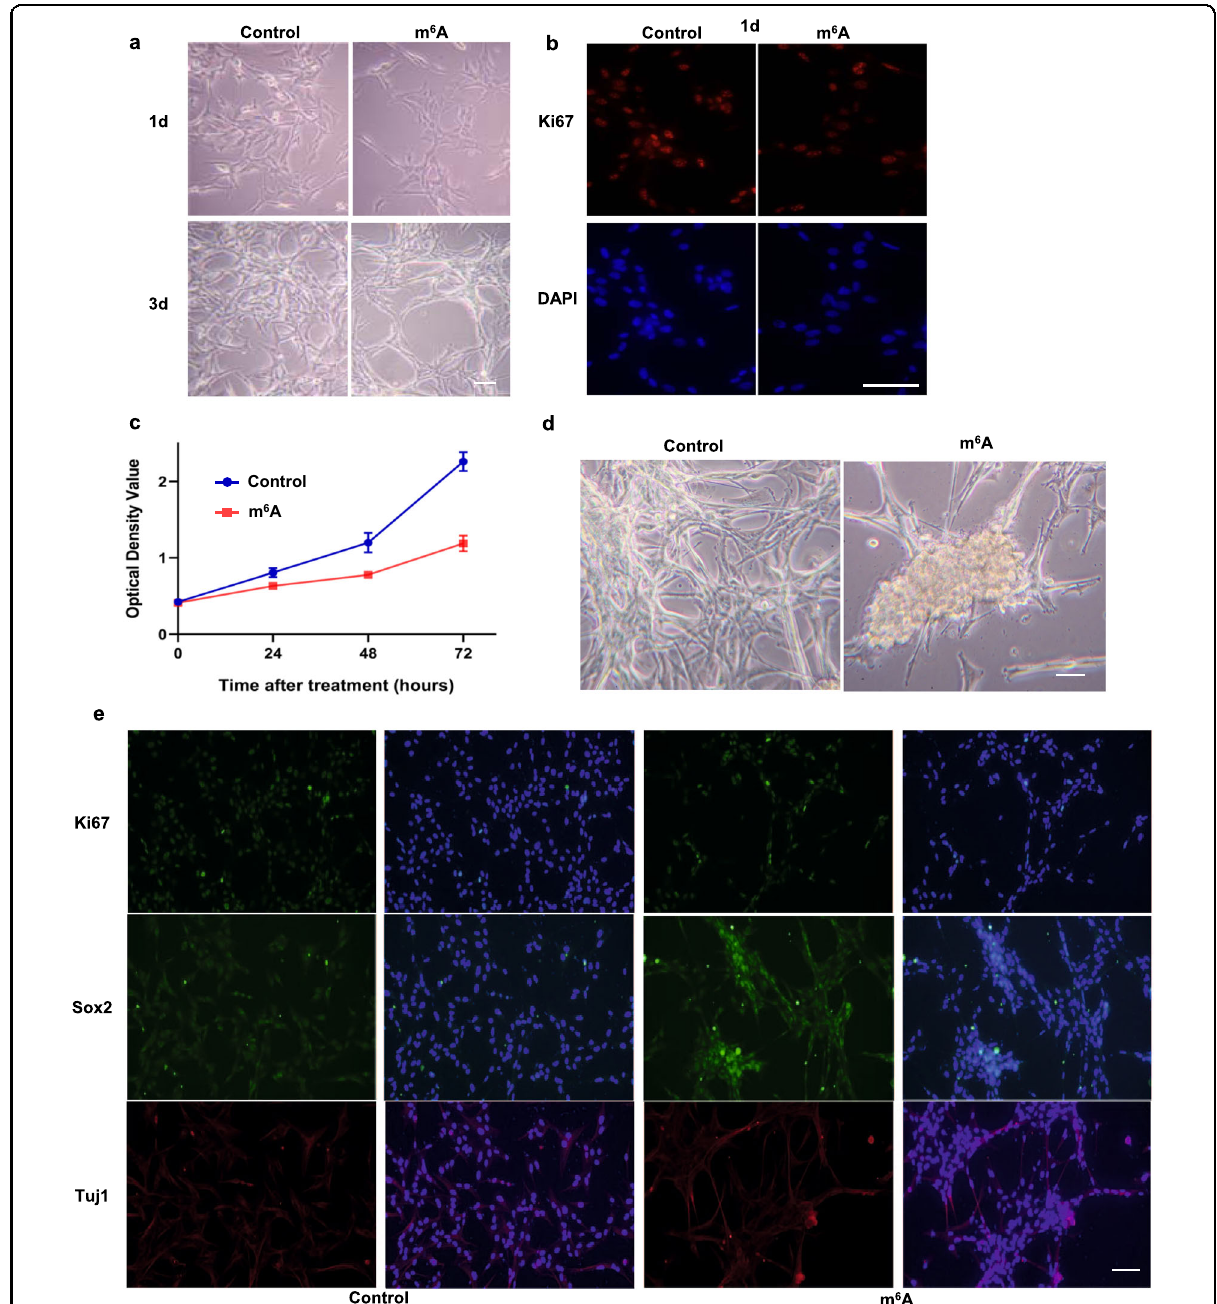
Fig. 8 m 6 A treatment selectively preserves a subset of the cells and stimulates their stemness and proliferation. a – c Progressive inhibition of U87 cell proliferation by m 6 A treatment, as shown by phase light images ( a ), Ki67 staining ( b ), and CCK8 assay ( c ). Scale bar: 50 μ m. d , e Selective preservation of a subset of GBM cells with potential stem cell-like properties. Formation of neurosphere-like structures with m 6 A treatment ( d ); Strong Ki67 ( e , upper panel) and Sox2 staining ( e , middle panel) with the neurosphere-like objects; Enhanced Tuj1 staining at the peripherals of the neurosphere-like objects ( e , lower panel). Scale bar: 50 μ